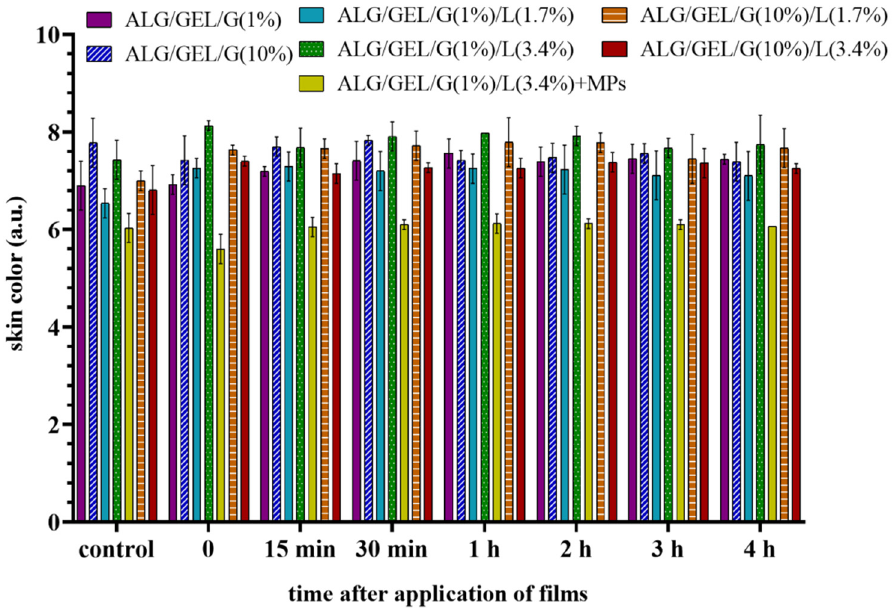
Figure 8. Skin color after application of films based on sodium alginate and gelatin with different amounts of glycerol and lipids, as well as the sample with incorporated PLA microparticles. The control measurements were performed before the application of materials to the skin, whereas time = 0 refers to the tests taken immediately after removal of the films that had been applied to the skin for 10 min. * indicates a difference at p < 0.05 between the results at an appropriate time compared to the results made for the control field.